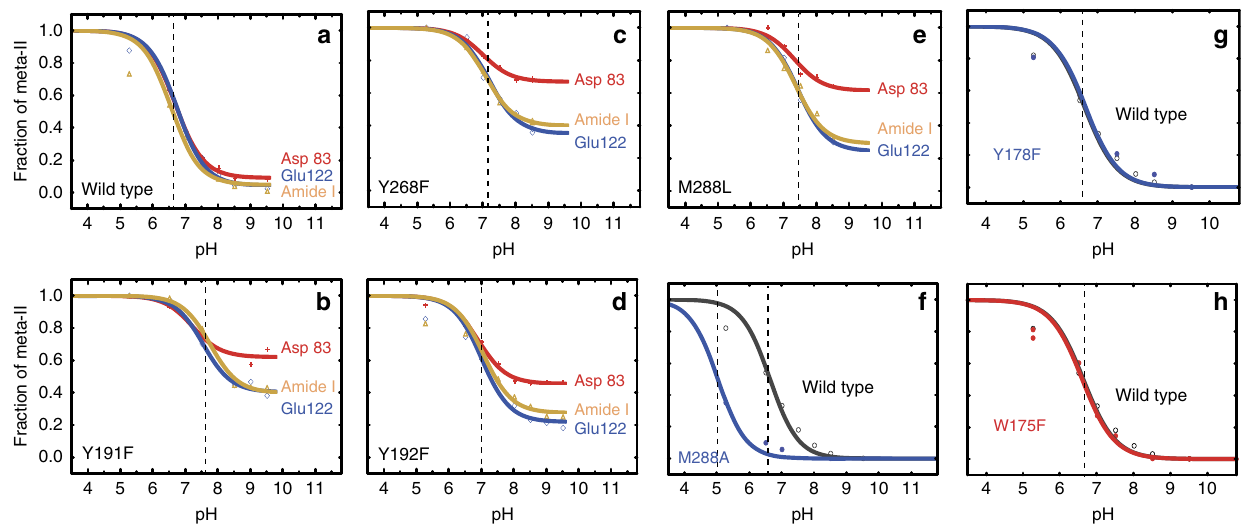
Figure 4 | FTIR analysis of rhodopsin. Wild-type ( a ), and the Y268F ( b ), Y191F ( c ), Y192F ( d ), M288L ( e ), M288A ( f ), Y178F ( g ) and W175F ( h ) mutants. FTIR difference spectra were obtained at 0 (cid:2) C as a function of pH, and the relative contributions of Meta-I and Meta-IIbH þ were determined on the basis of reference spectra (Supplementary Fig. 7). Spectral decomposition was performed between 1,800 and 1,600cm (cid:2) 1 . This range is the most diagnostic of the Meta-I–Meta-II transition and comprises the amide I vibrations of the protein backbone and the C ¼ O stretch of protonated carboxylic acids Glu122 3.37 and Asp83 2.50 . The vertical dashed lines are at the positions of the inflection